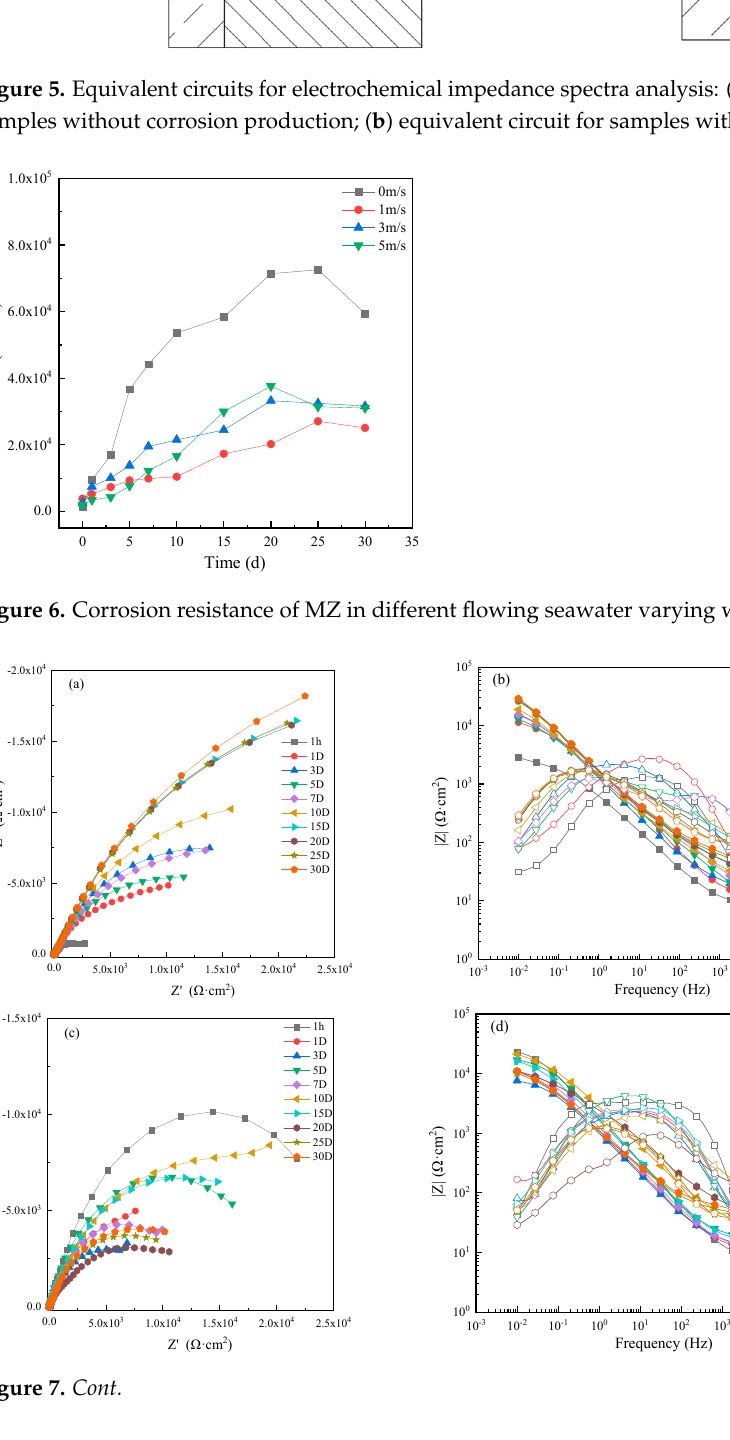
Figure 5. Equivalent circuits for electrochemical impedance spectra analysis: ( a ) equivalent circuit for samples without corrosion production; ( b ) equivalent circuit for samples with corrosion produc- tion.